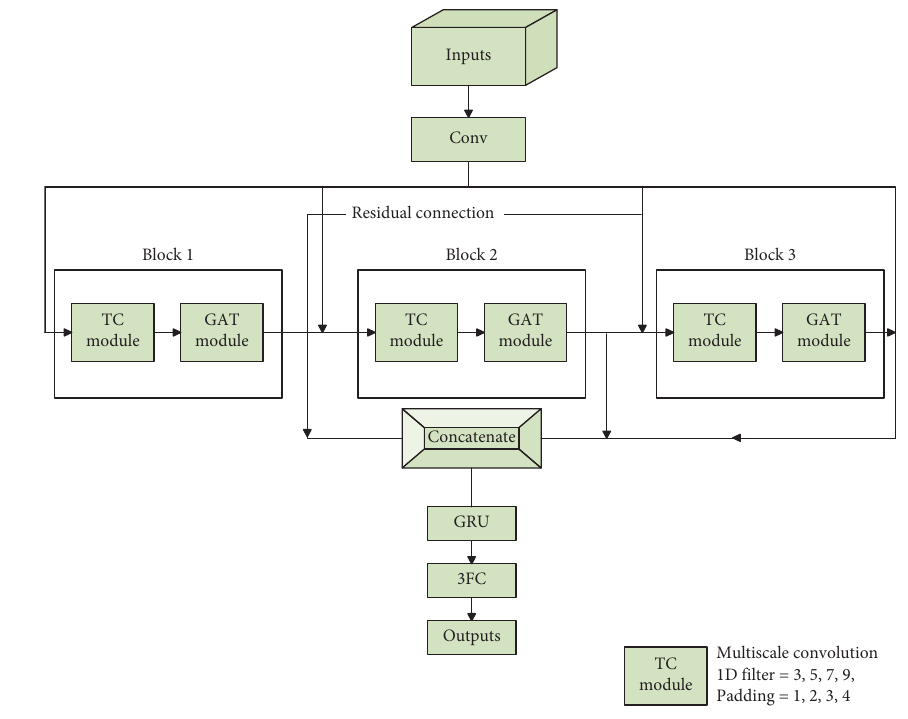
Figure 2: Forecasting model.